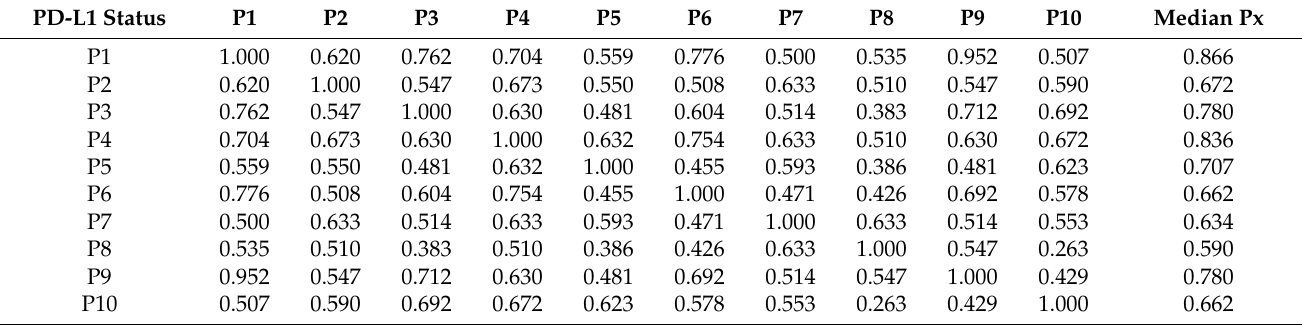
Table 3. Cohen’s Kappa values per pathologist duo for PD-L1 status in the study set.